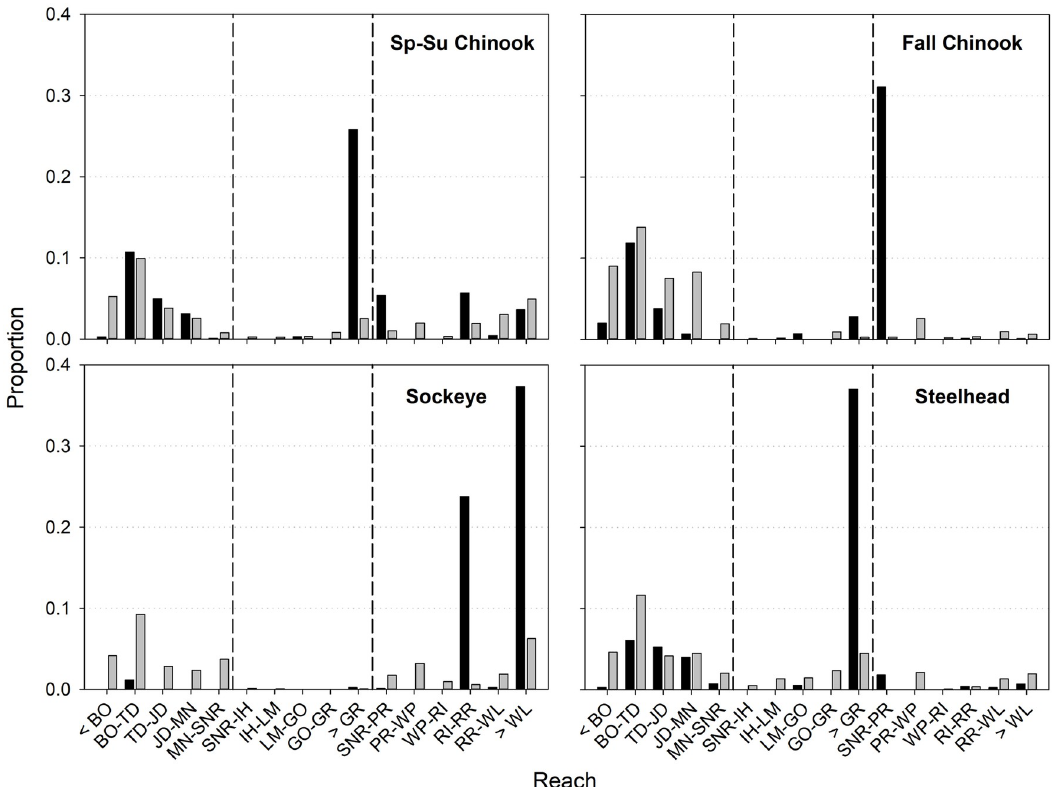
Fig 4. Distributions of final detection locations for radio-tagged Chinook Salmon, Sockeye Salmon, and steelhead among Columbia and Snake River reaches. Black bars represent final detections in tributaries and hatcheries and gray bars represent last detections in main stem reaches, with reported harvest and unknown fate combined. Vertical dashed lines separate the lower Columbia River (left), Snake River (SNR, middle), and mid-Columbia River (right). See Fig 1 for dam